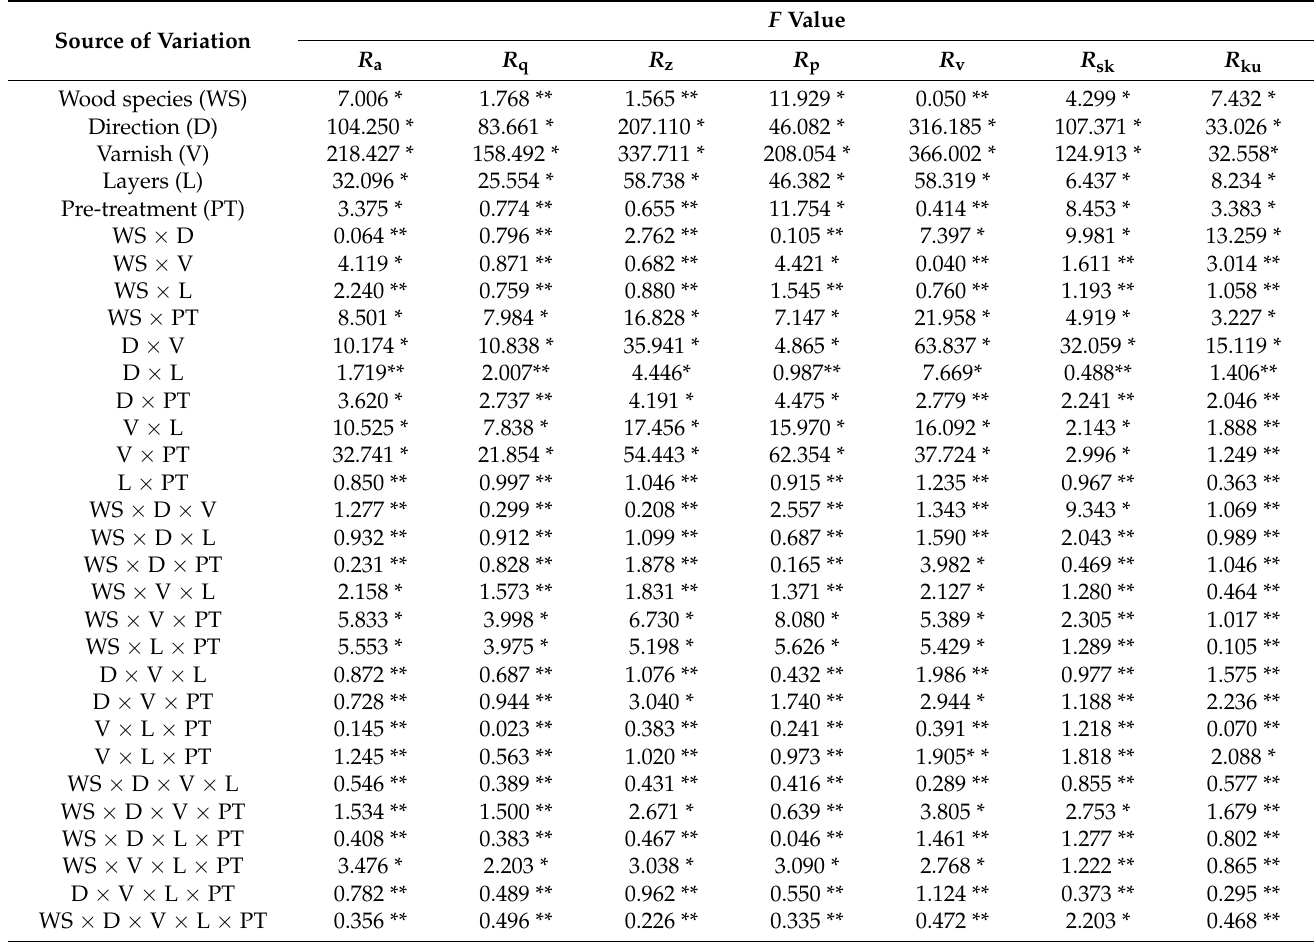
Table 3. Analysis of variance of surface roughness for varnished samples.